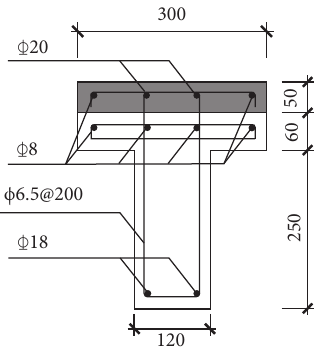
Figure 5: Reinforcement of the cross section at the middle support.